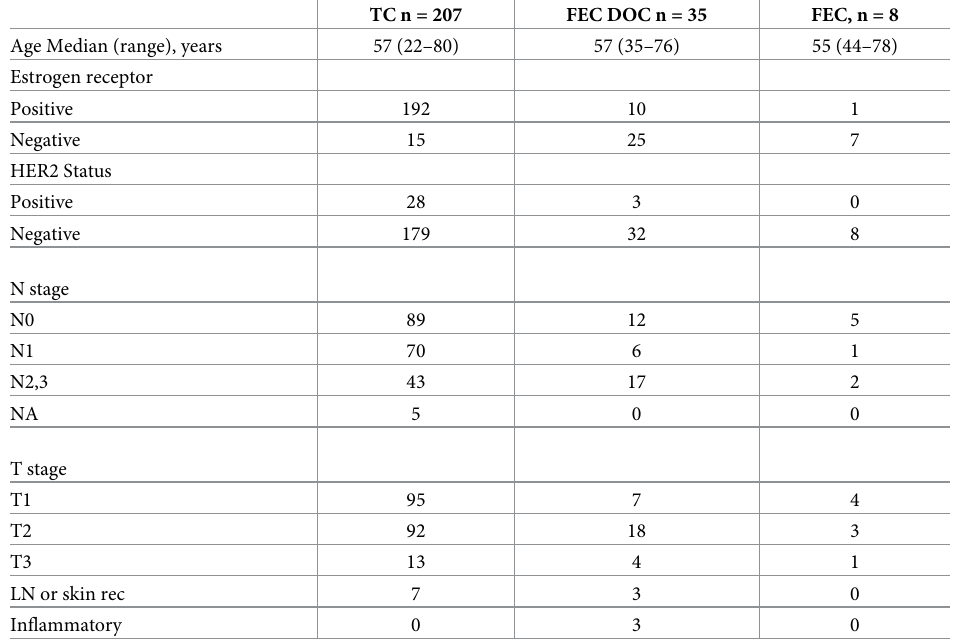
Table 1. Patient and tumor characteristics (n = 250).